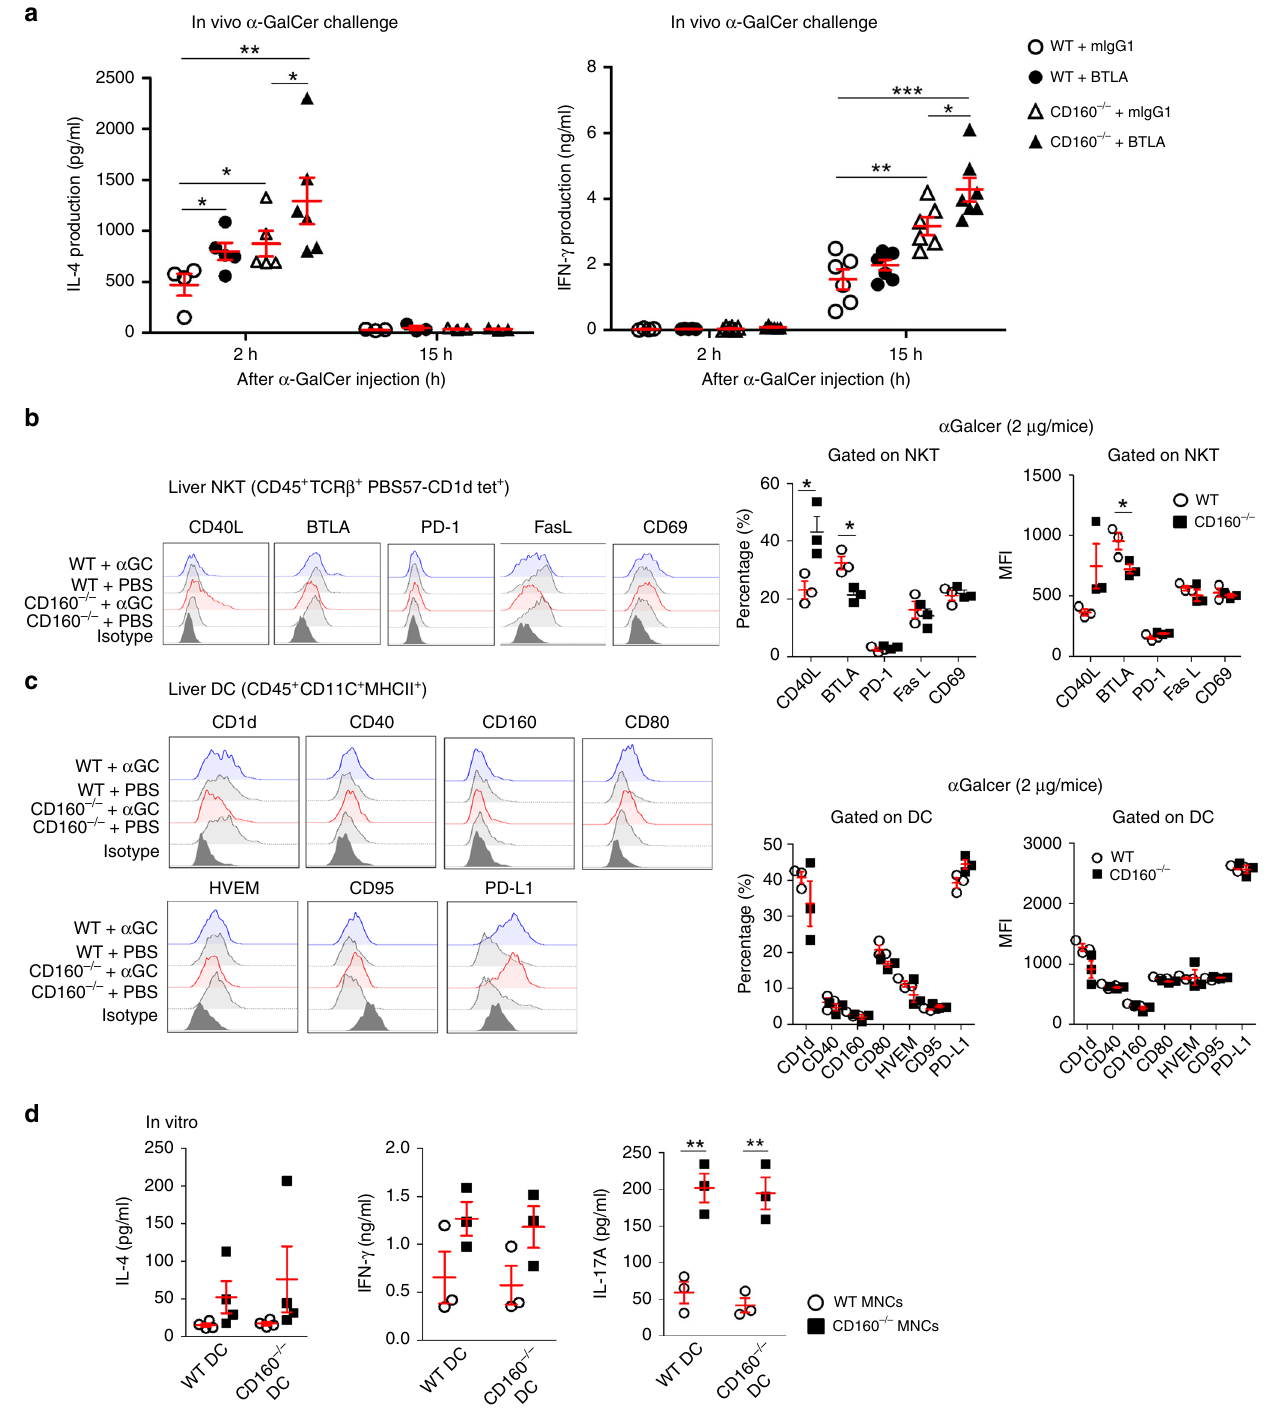
Fig. 5 α -GalCer challenge in the presence of BTLA blocking mAbs in CD160 − / − mice. a mIgG1 or anti-BTLA mAbs were injected into WT or CD160 − / − mice 2 h prior to α -GalCer in vivo challenge and serum levels of IL-4 and IFN- γ were measured by CBA 2 and 15 h post α -GalCer challenge ( n = 3 – 7 per group). Surface expression of co-stimulatory and co-inhibitory receptors on NKT ( b ) and dendritic cells ( c ) from WT and CD160 − / − mice 4 h before and after 2 μ g of α -GalCer challenge in vivo. Left: Representative FACs plots from three independent experiments. Right: Average percentages or MFIs were plotted for each receptor as bar graphs ( n = 3 – 5 per each group). d Co-cultures of WT or CD160 − / − liver MNCs with WT or CD160 − / − BMDCs for 48 h in vitro. BMDCs were pulsed with α -GalCer for 16 h prior to co-culture ( n = 3 – 4 per group). All data are presented as mean ± S.E.M. * P < 0.05, ** P < 0.01, *** P < 0.001 with an unpaired two-tailed T